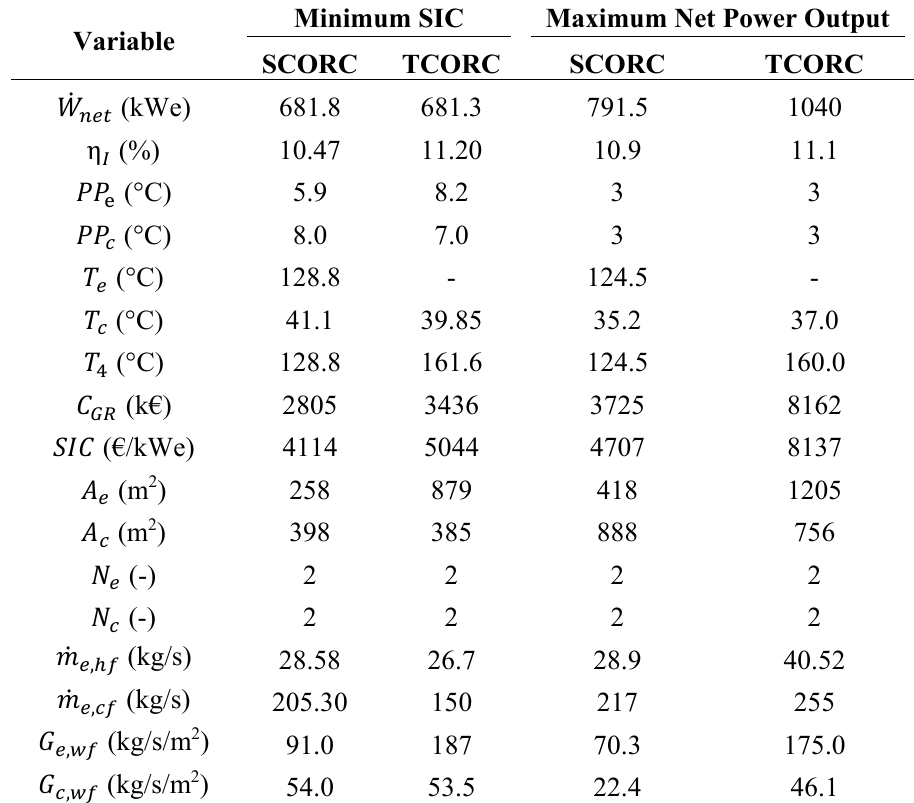
Table 10. Results of minimum specific investment cost (SIC) and maximum net power output ( (cid:1849)(cid:4662)